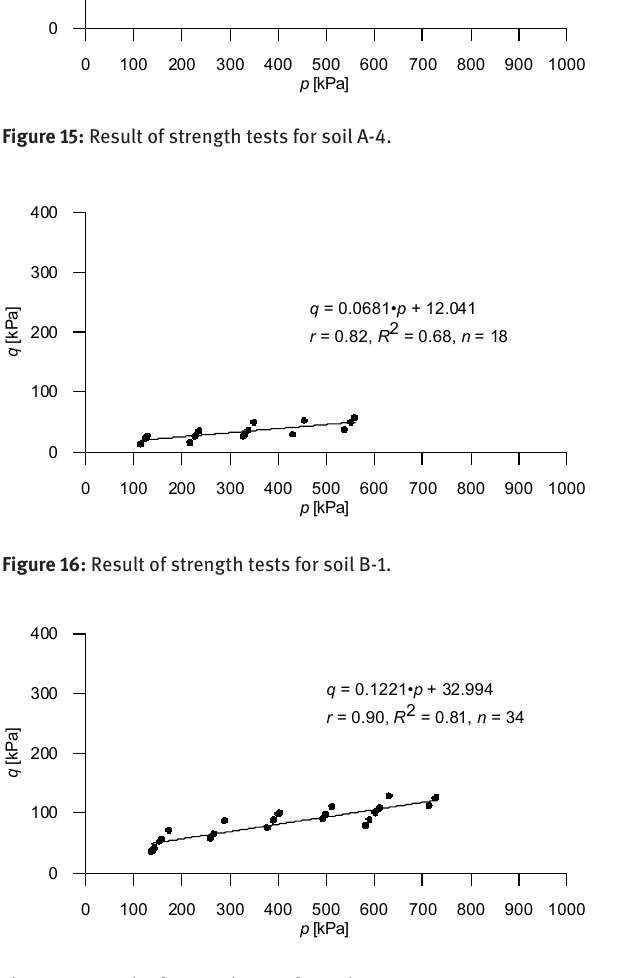
Figure 17: Result of strength tests for soil B-2.